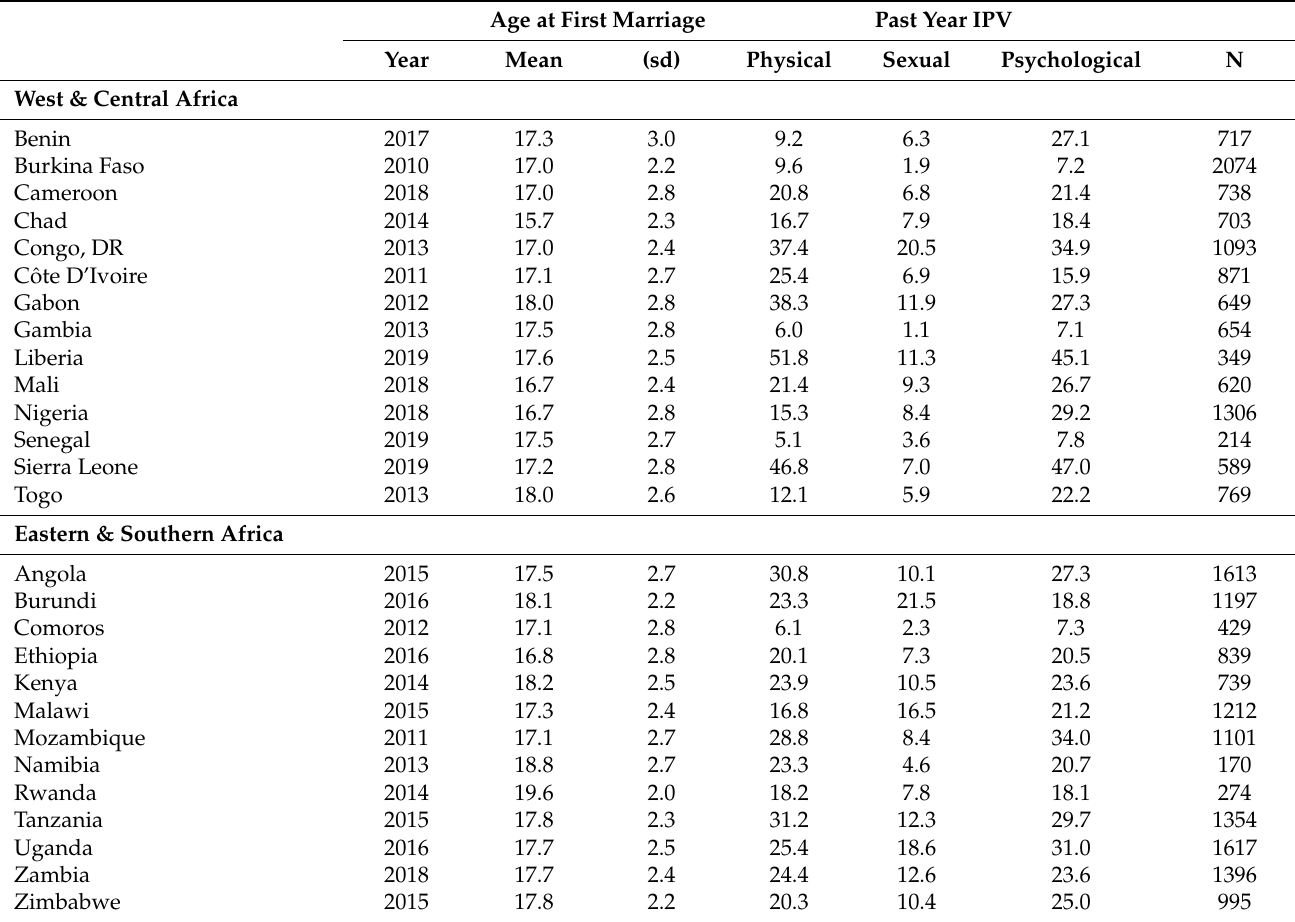
Table 1. Child marriage and intimate partner violence among women aged 20–24 years by UNICEF world regions. Demographic and Health Surveys